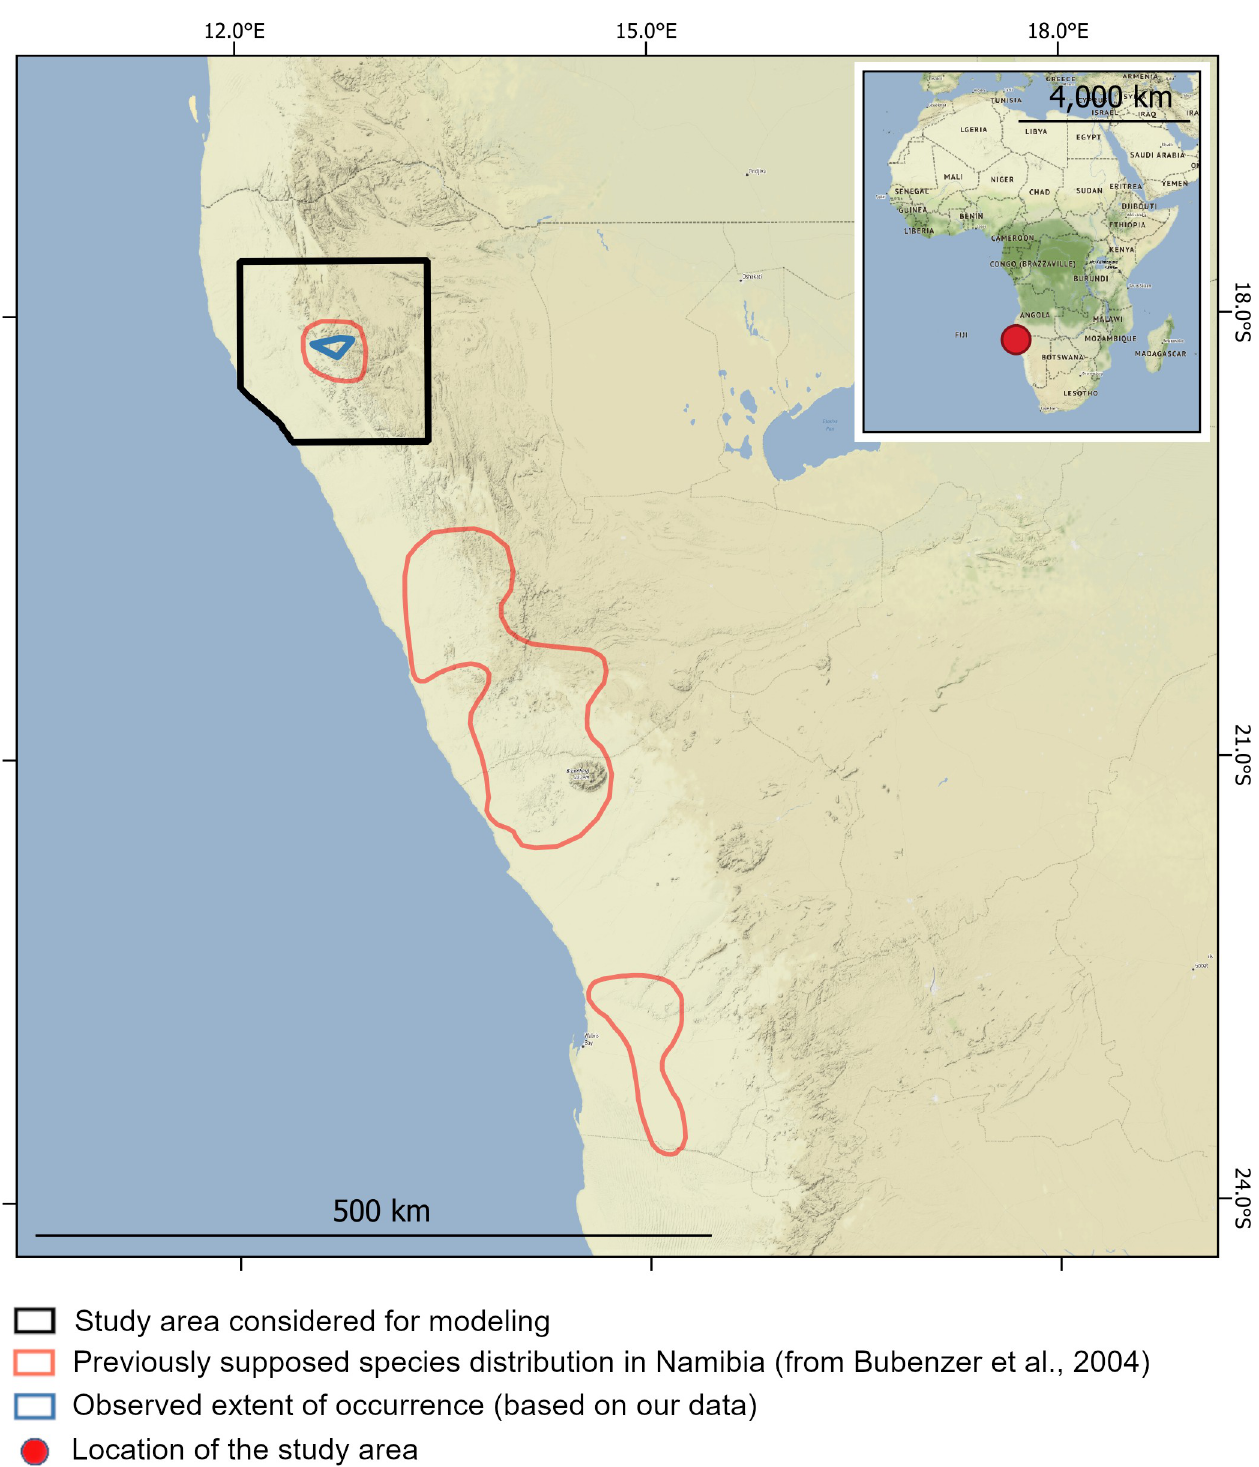
Fig 1. Distribution of Welwitschia mirabilis in Namibia and location of the study area. In the main map, the black polygon indicates the study area, the red polygons show the known species distribution, and the blue polygons represent the boundaries of the observed extent of occurrence in Northern Namibia. In the inset map the red circle indicates the general location of the study area in Africa. Map tiles by Stamen Design, under CC BY 3.0.